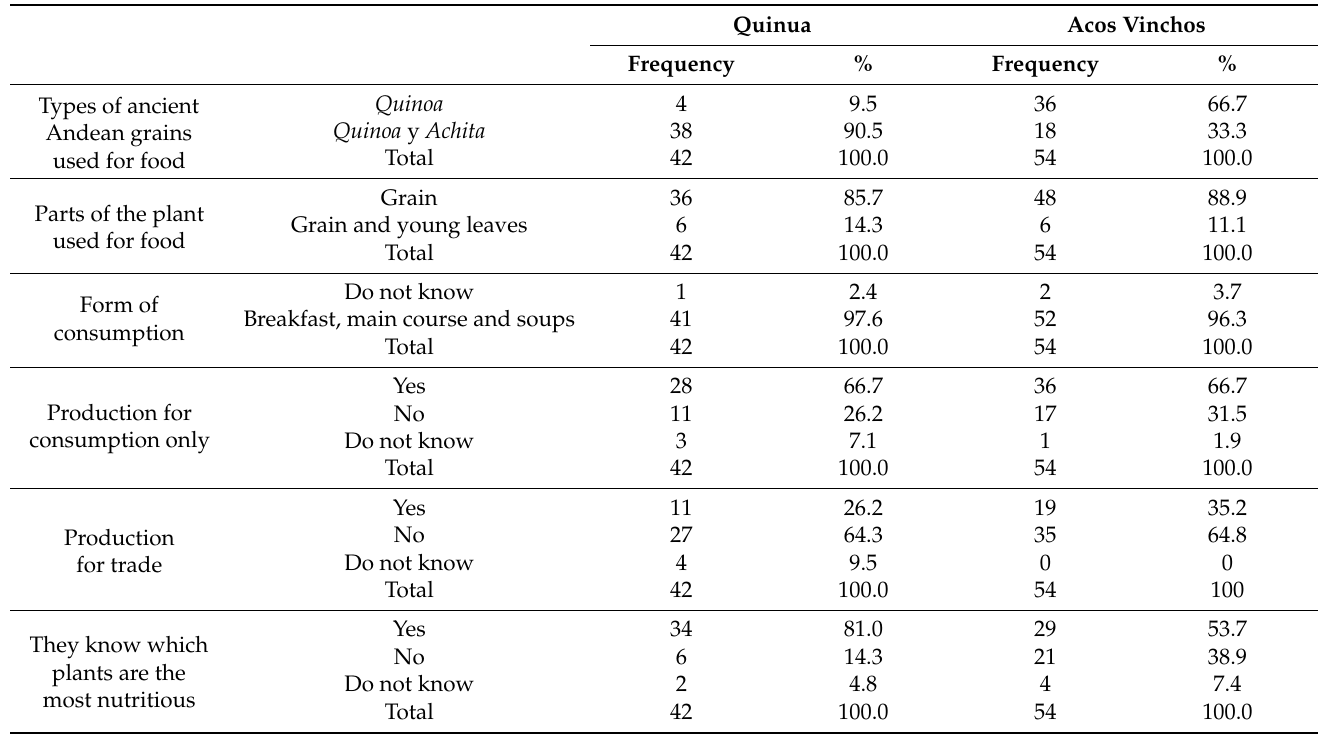
Table 3. Food use and production of ancestral Andean grains in the districts of Quinua and Acos